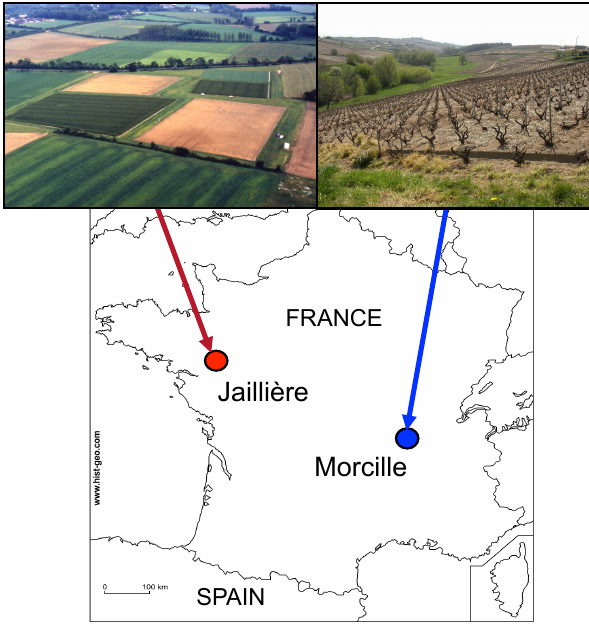
Figure 3. Location of experimental VFS sites: Jaillière, north- western France, maize crops on a flat silty-clay soil in a temper- ate oceanic climate; Morcille, southeastern France, vineyards on a sandy-loam soil in a Mediterranean semicontinental climate. Jail- lière is located at 47 ◦ 27 (cid:48) 6.25 (cid:48)(cid:48) N, 0 ◦ 57 (cid:48) 58.37 (cid:48)(cid:48) W and Morcille is located at 46 ◦ 10 (cid:48) 31.3 (cid:48)(cid:48) N, 4 ◦ 38 (cid:48) 11.2 (cid:48)(cid:48) E, in GPS